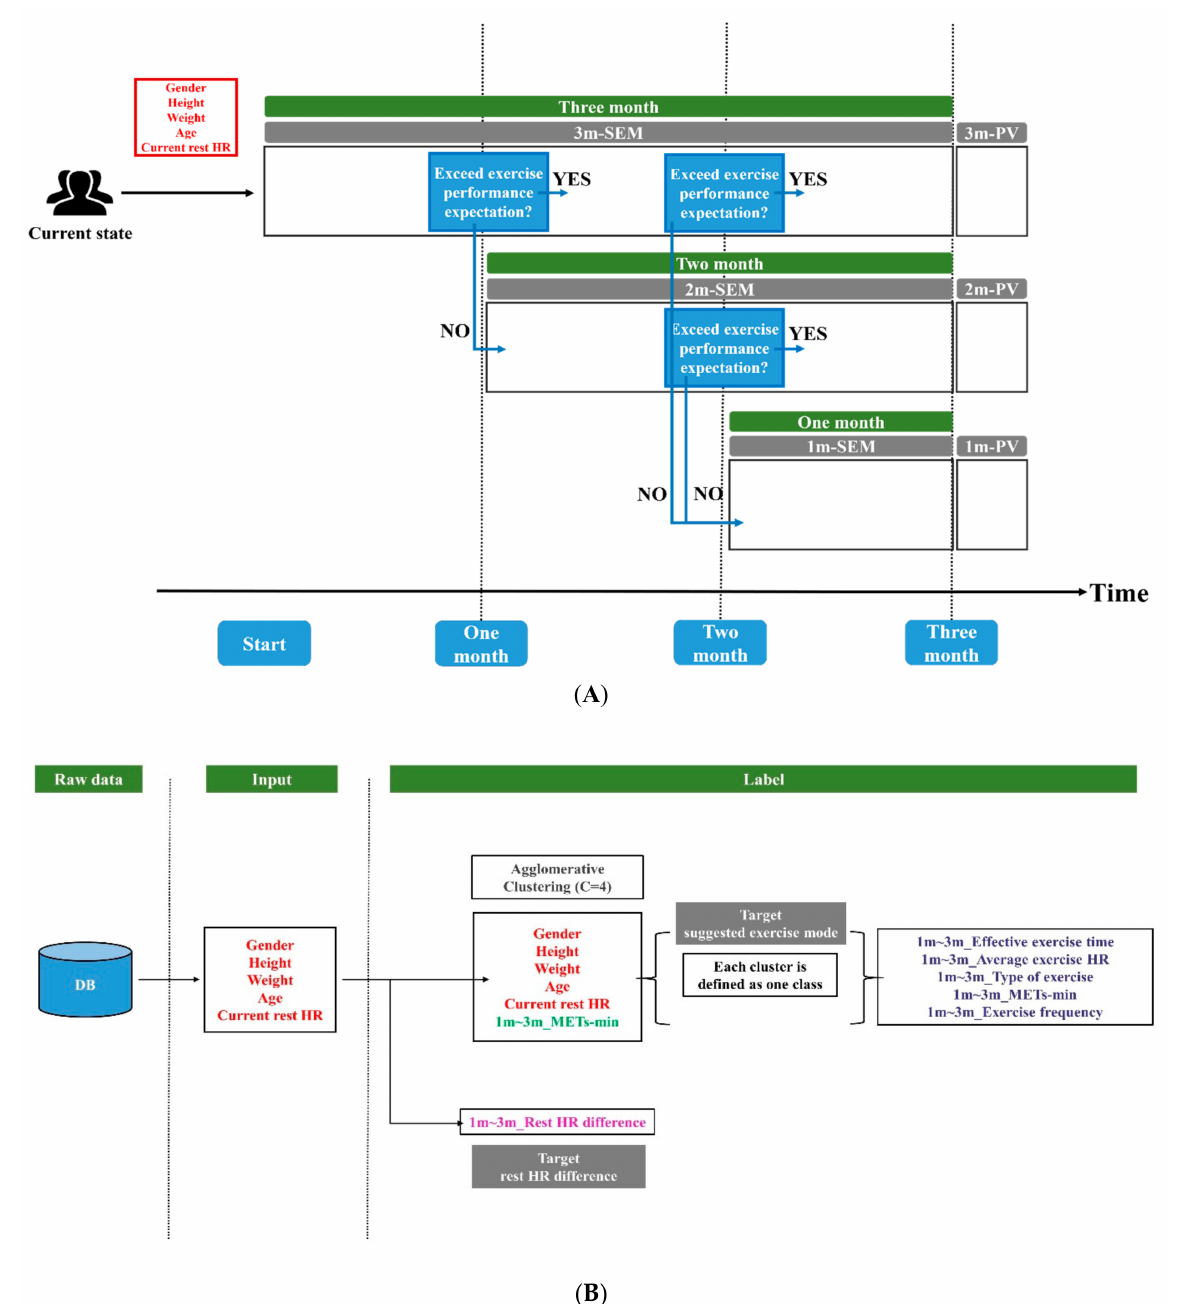
Figure 1. ( A ) The exercise scenario of this study; ( B ) The flowchart to define input data and target of SEM modules and PV modules. SEM: suggested exercise mode. PV: predicted value of rest HR difference after following suggested exercise